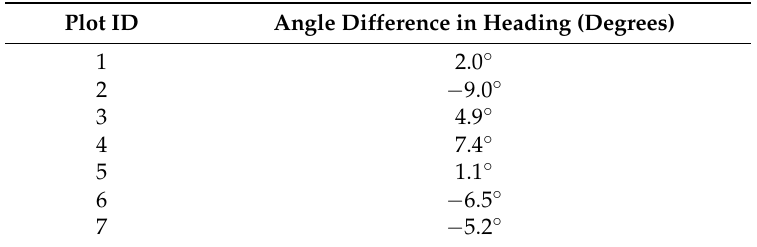
Table 3. The heading error in the magnetometer readings, found by comparing the estimated tree positions from the terrestrial laser scanner method and the tree position from the reference.